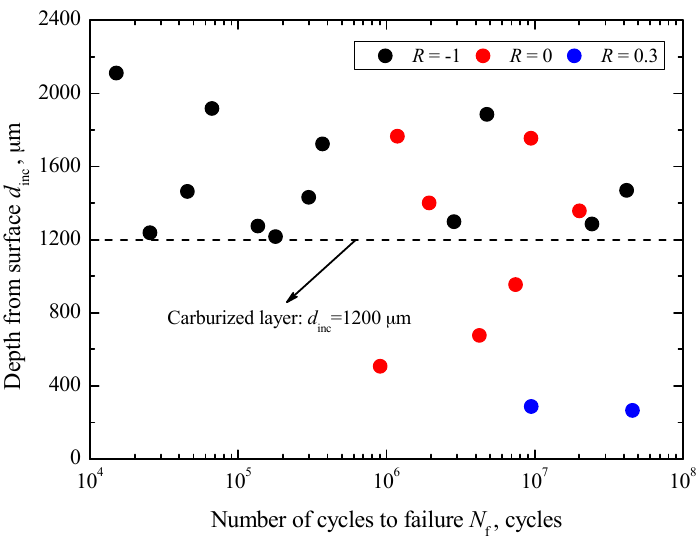
Figure 7. Relationship between d inc and N f .